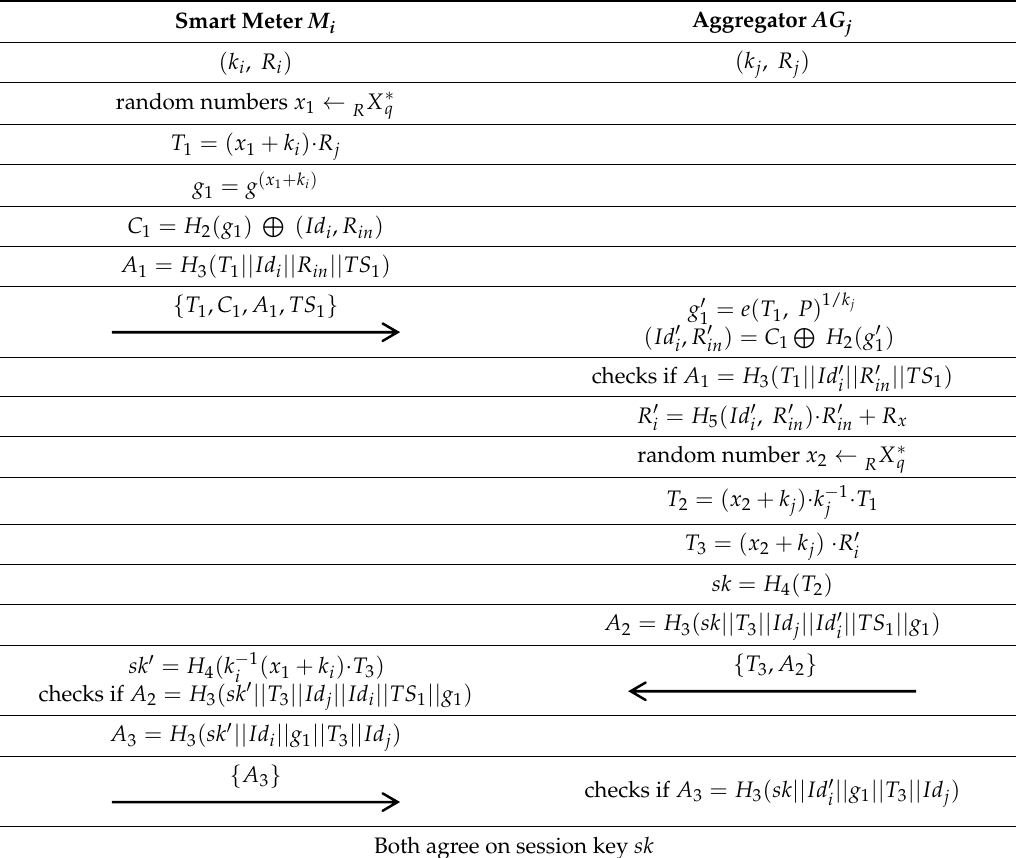
Table 8. Request and authentication phase of the proposed scheme.